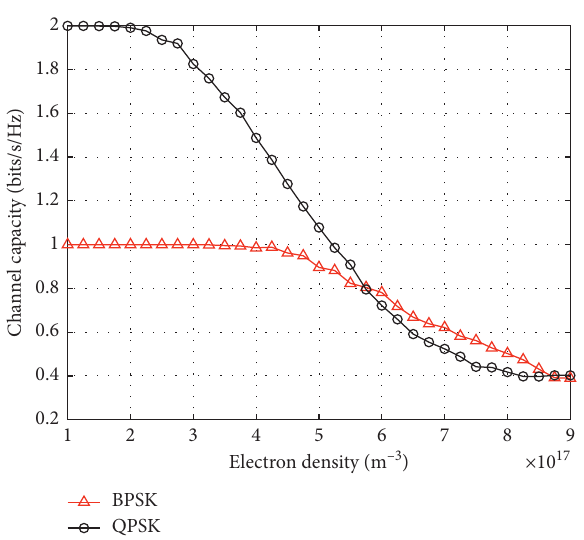
Figure 5: Influence of Ne on channel